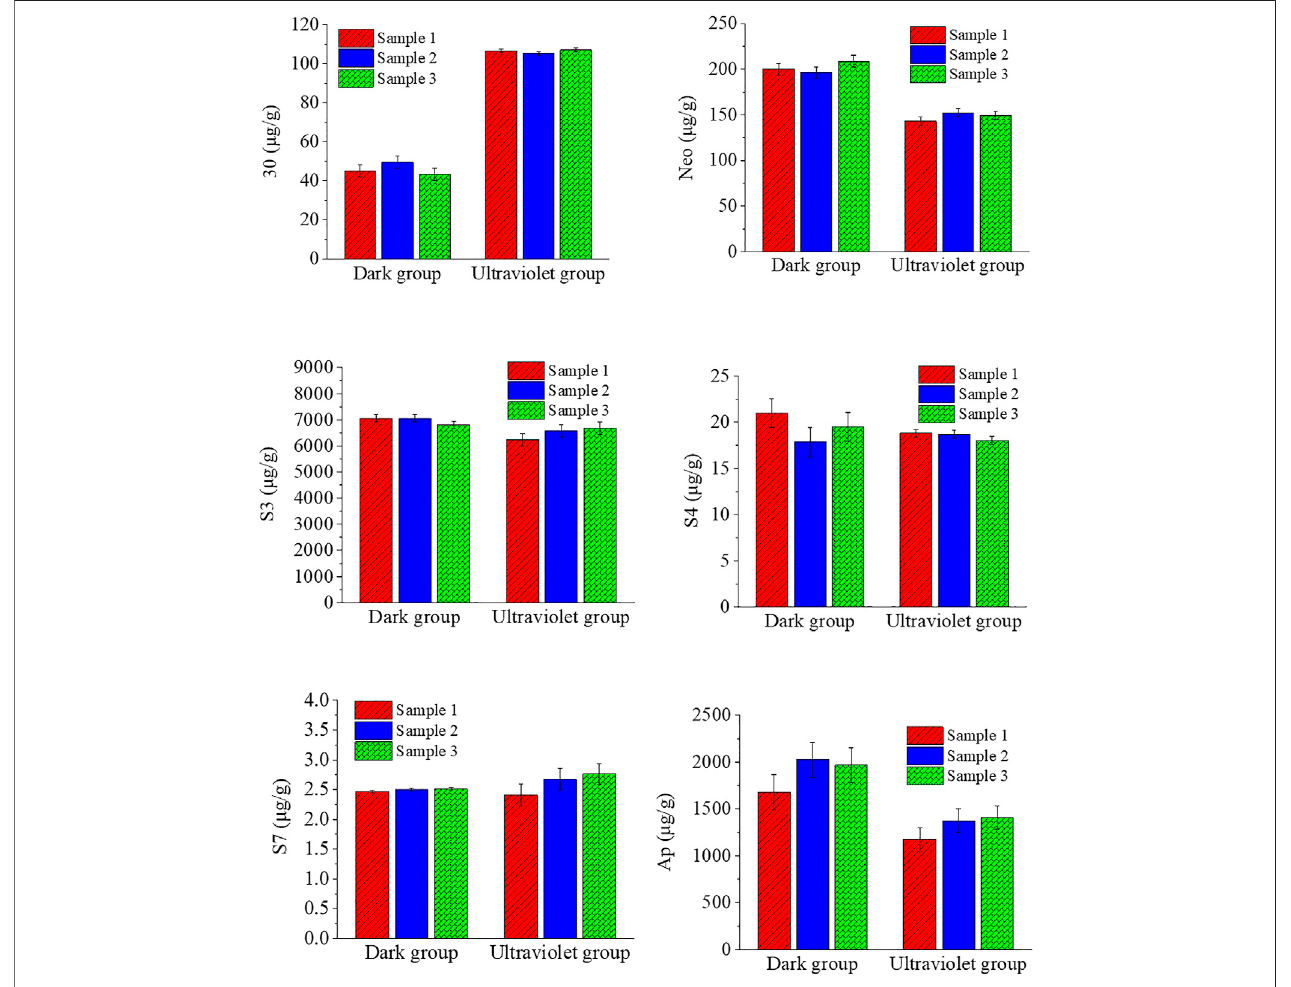
FIGURE 1 | Effect of ultraviolet light treatment on the chemical composition of A. paniculata seedlings.